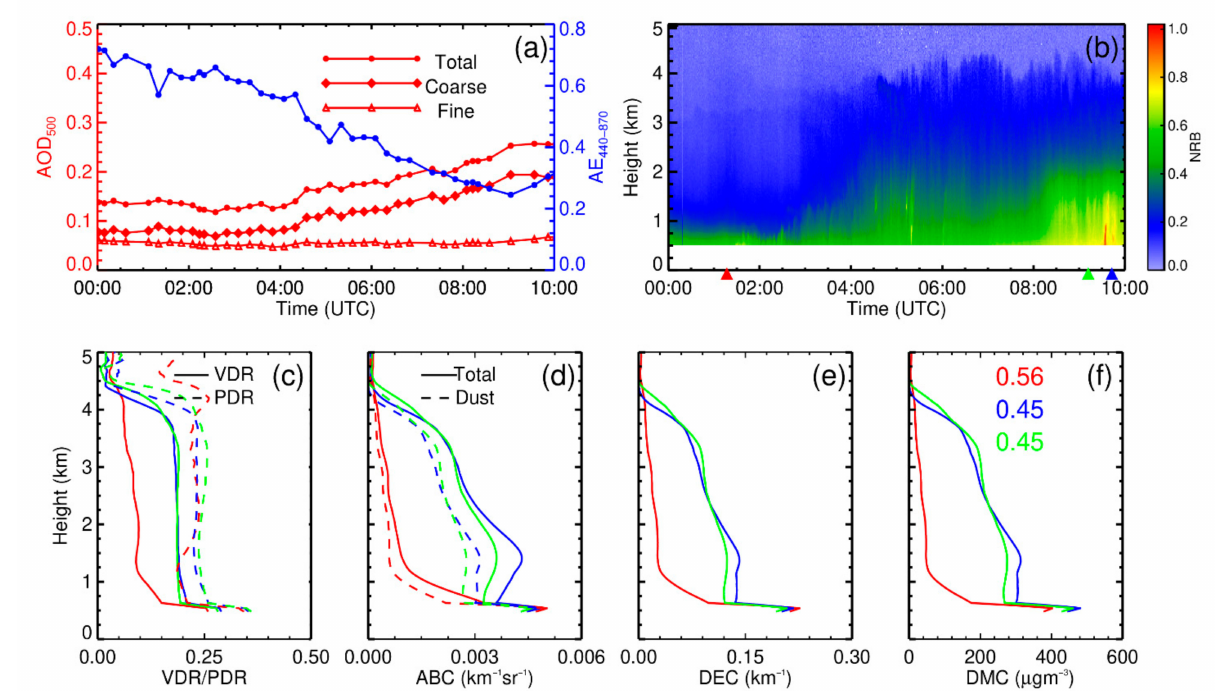
Figure 6. Same as Figure 5, but for a polluted dust case at Minqin on 22 May 2010. The color triangles on the horizontal axis in ( b ) correspond to 01:09, 09:04, and 09:35,